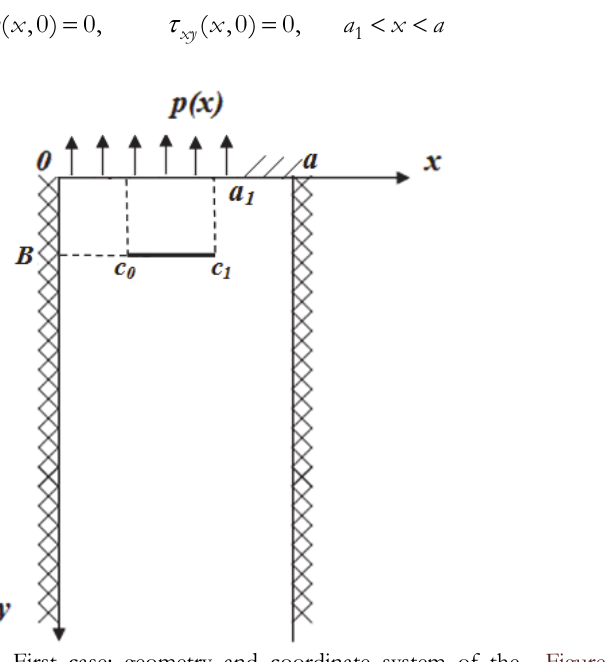
Figure 1: First case: geometry and coordinate system of the problem.